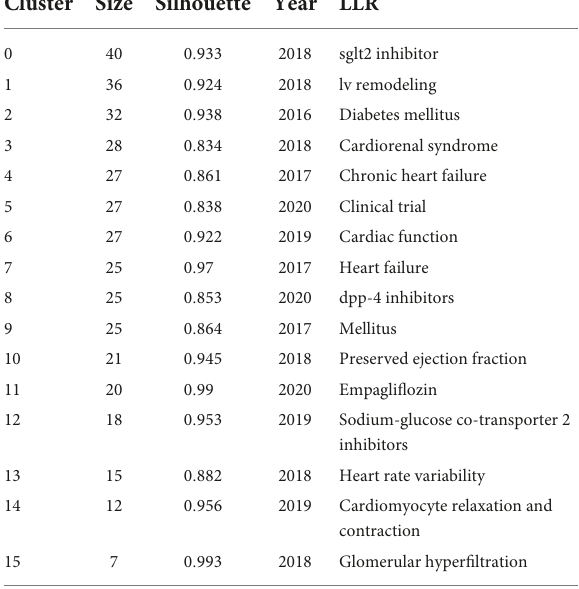
TABLE 10 The total 16 clusters of